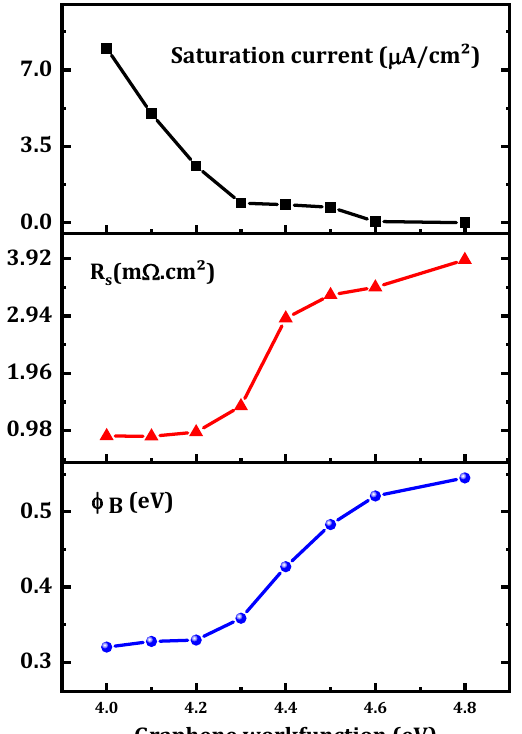
Figure 10. Variation in the output parameters of the proposed SBD versus the graphene workfunc- tion.